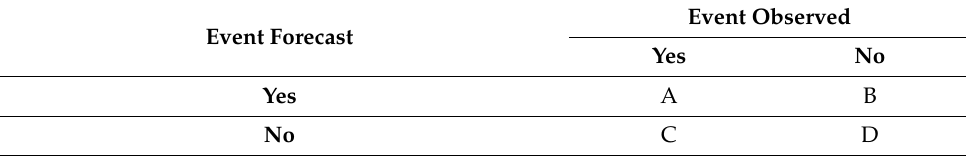
Table 5. Contingency table